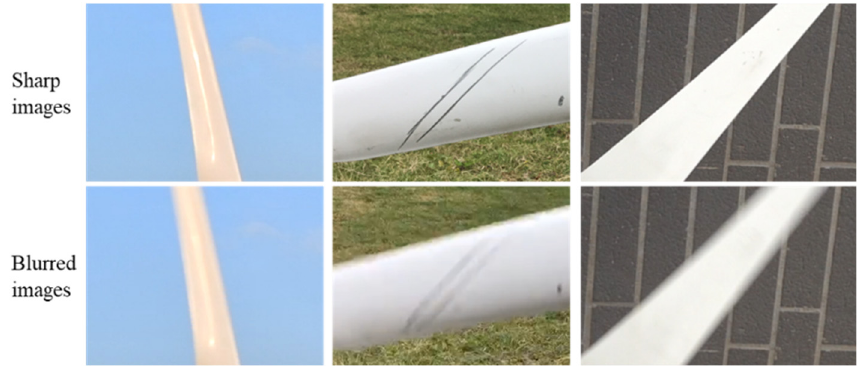
Figure 4. Three example images from dataset #1.